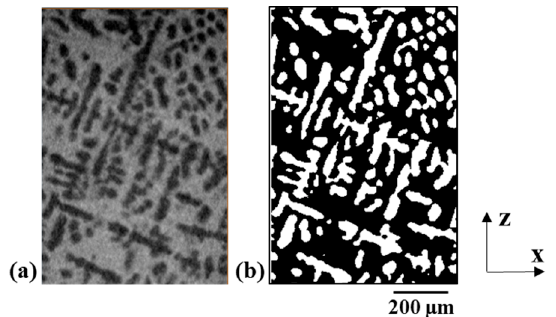
Figure 2. Representative image obtained in the x-z plane from the 3D data for the Sn 58 wt.% Bi alloy. ( a ) Grey value image displays the primary phase (dark grey) and eutectic phase (light grey). ( b ) Corresponding segmented primary phase (white).